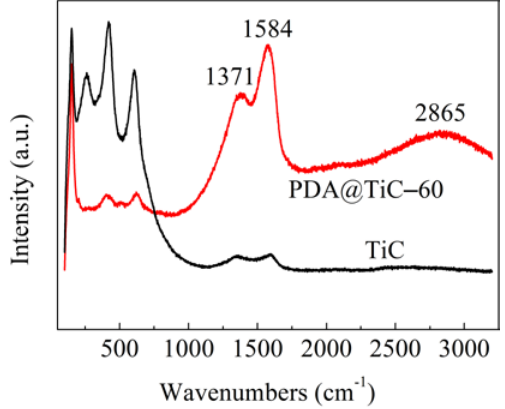
Figure 2. Raman spectra of TiC and PDA@TiC − 60.